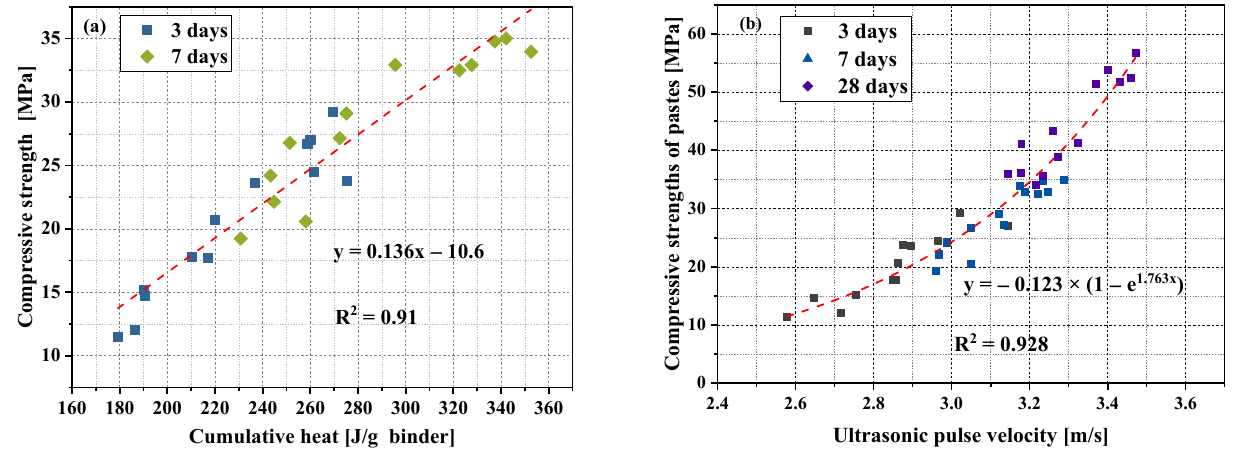
Figure 12. Relationships among various test results. ( a ) Relationships between cumulative hydration heat and compressive strength at curing ages of 3 days; ( b ) relationships between compressive strength and UPV at curing ages of 3, 7, and 28 days.